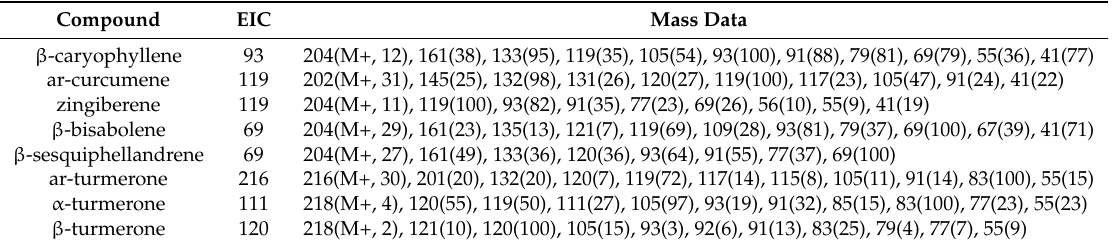
Table 2. Mass data of eight characteristic typical volatile compounds in C. longa .